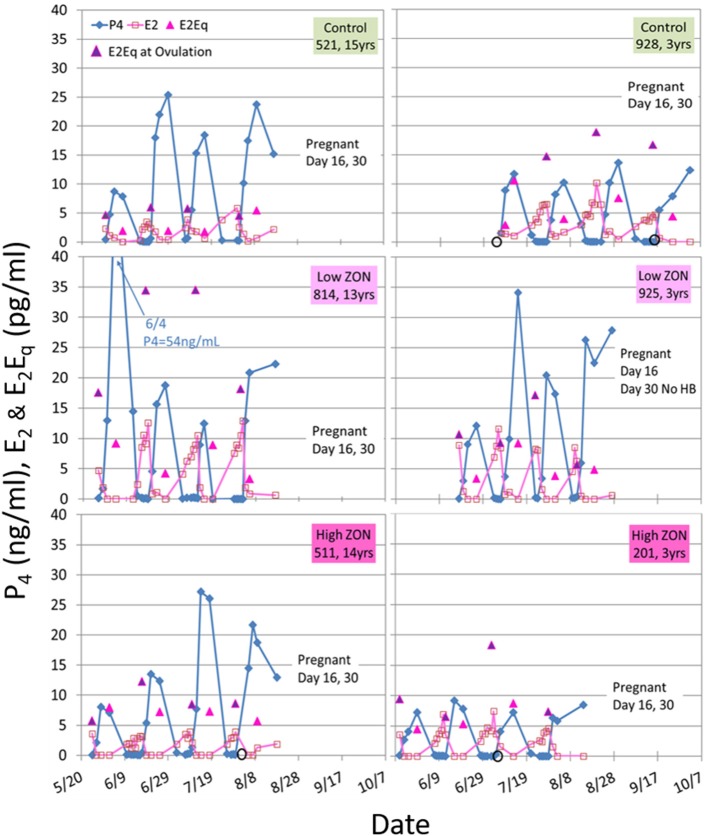
Estradiol (E2), progesterone (P4), and E2Eq values over three estrous cycles, and pregnancy status at the end of the 3rd ovulation after ZON treatment. The left side are older mares (13–15 years old) and the right side are 3-year old maidens. Estrogenic activity on the day of ovulation is indicated by the  E2Eq. Ovulation is indicated by  when missing a sample. Pregnancy was determined by ultrasound at Day 16, and fetal heartbeat at Day 30. The x-axis spans May 20 to October 7, as mares were started on the study on different dates based on their initial ovulatory events.